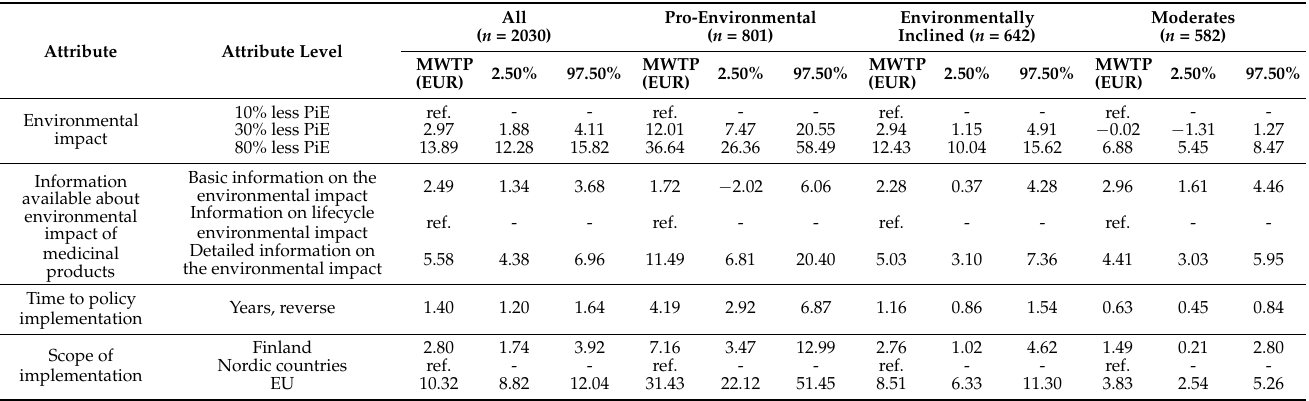
Table 6. MWTPs for implementations of different environmental classification systems for